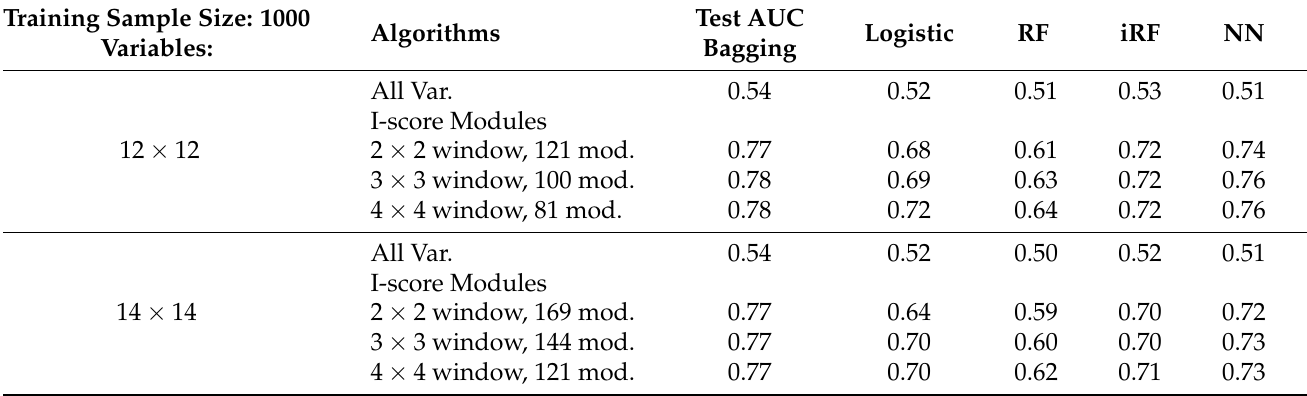
Table 7. The simulation results for Model (12). The theoretical prediction rate was calculated using Equations (13) as 75%. In other words, we expected the prediction performance on the out-of-sample test set to be approximately 75% on average. For each experiment below, the out-of-sample test set had 1000 sample data points and the performance was calculated using the AUC from the ROC (see Section 4.4 for detailed discussion of AUC values). Continuing from Table 6, we fixed the in-sample training size to 1000 data points and we allowed the of variables in the toy data to be 100 or 200. From 49 variables, this is a more challenging situation because it lowers the chance of finding the correct variable